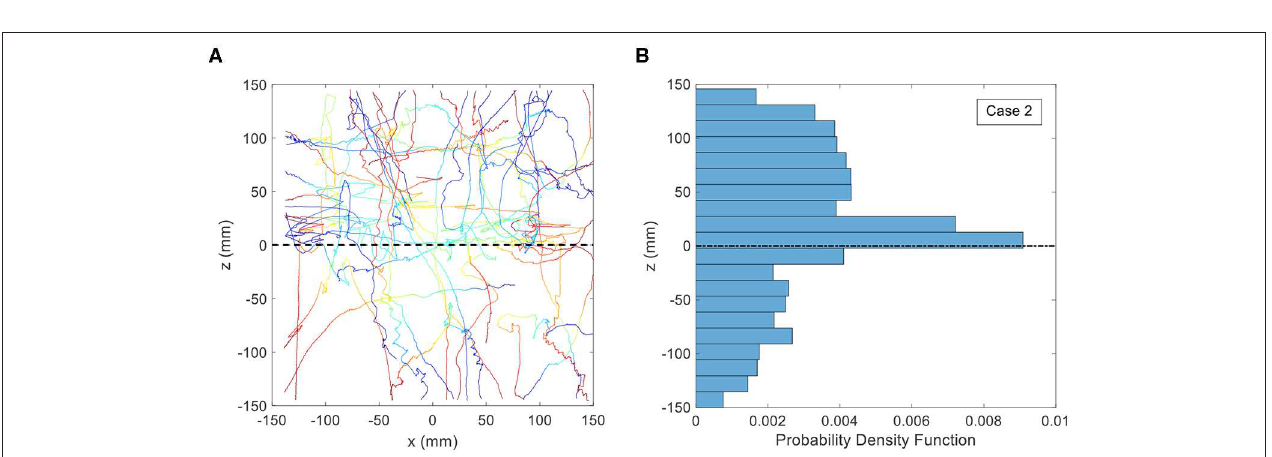
FIGURE 7 | (A) Copepod trajectories for the treatment consisting of a stagnant density jump of 1.0 σ t . The black dashed line indicates the location of the density interface. Color indicates the passage of time with blue corresponding to the beginning of the trajectory and red corresponding to the end. Although shown on the same plot, these trajectories were not collected simultaneously. (B) Probability Distribution Function (PDF) of copepod position in the vertical direction for the treatment consisting of a stagnant density jump of 1.0 σ t